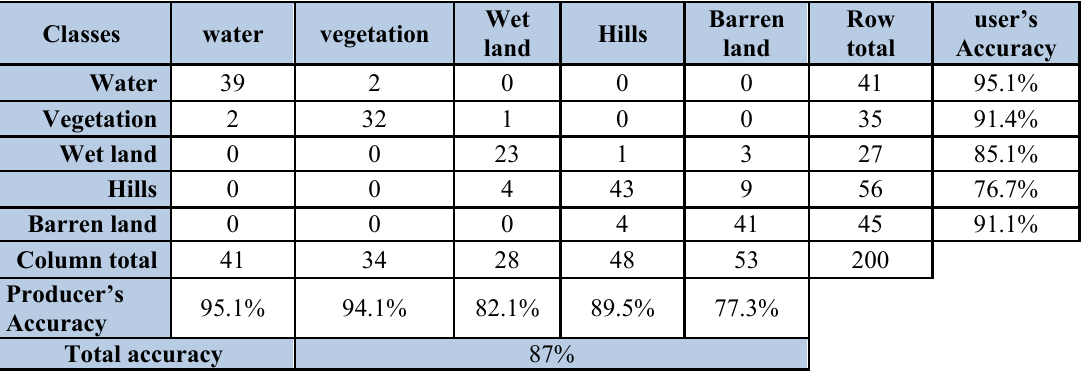
Table 6: Error matrix with producers, users, and overall accuracy calculations for unsupervised classification using mean value for Landsat-7